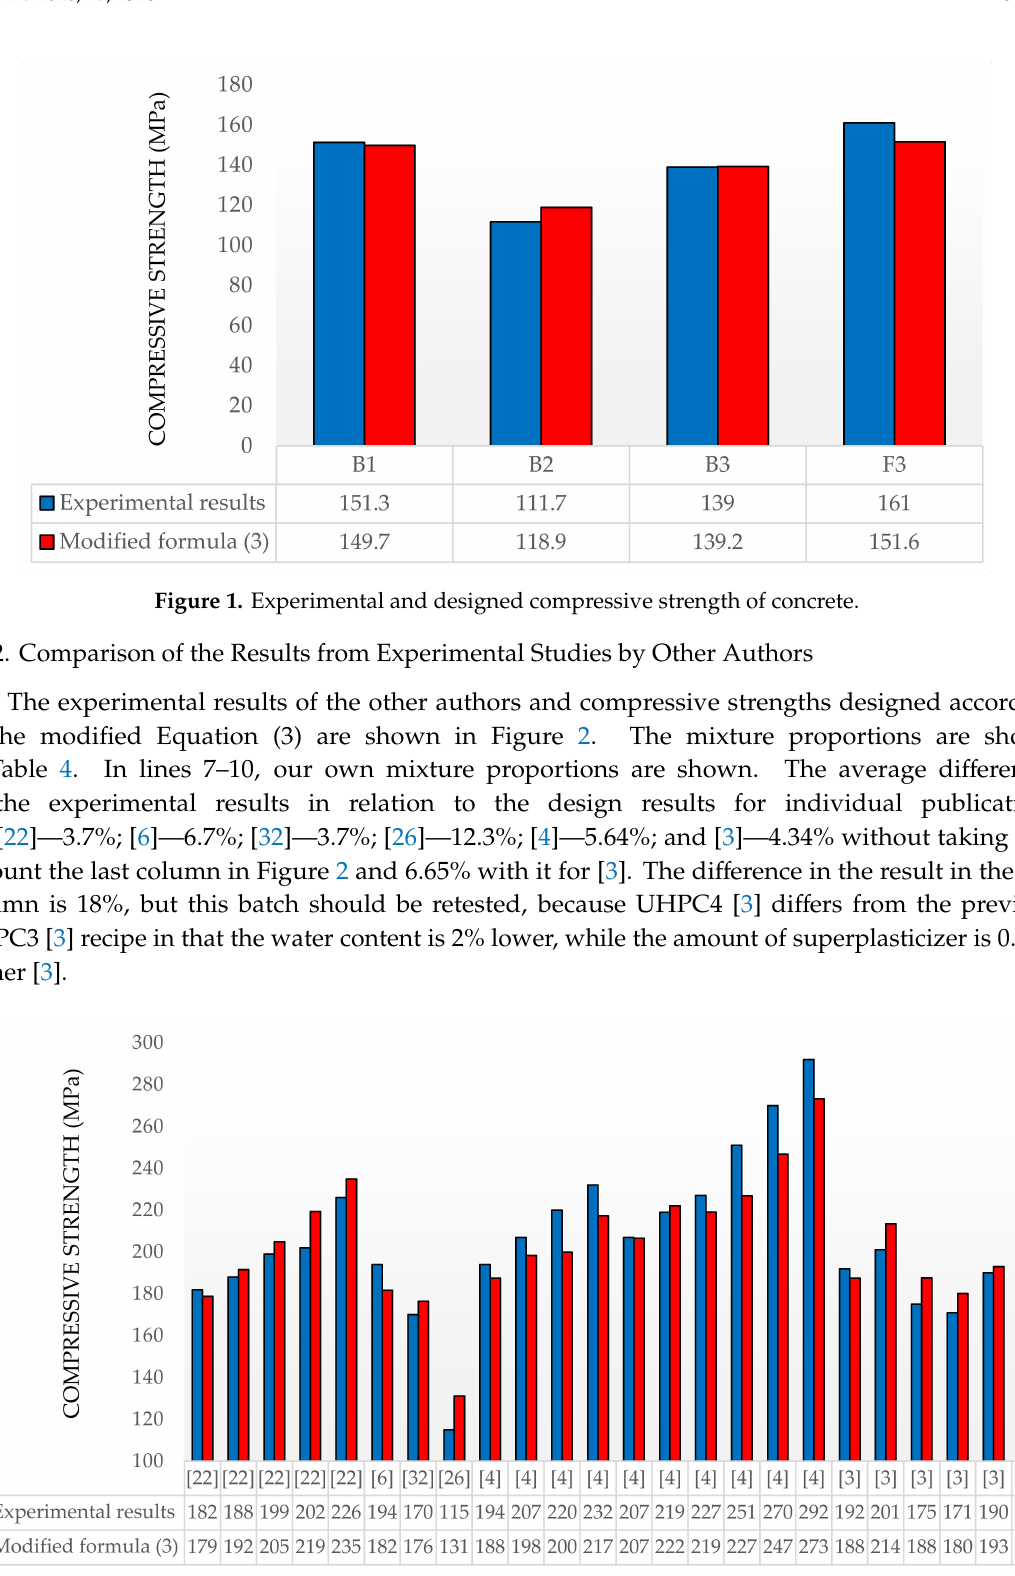
Figure 2. Compressive strength of concrete—experimental results taken from literature [3,4,6,22,26,32] vs. estimations based on the modified